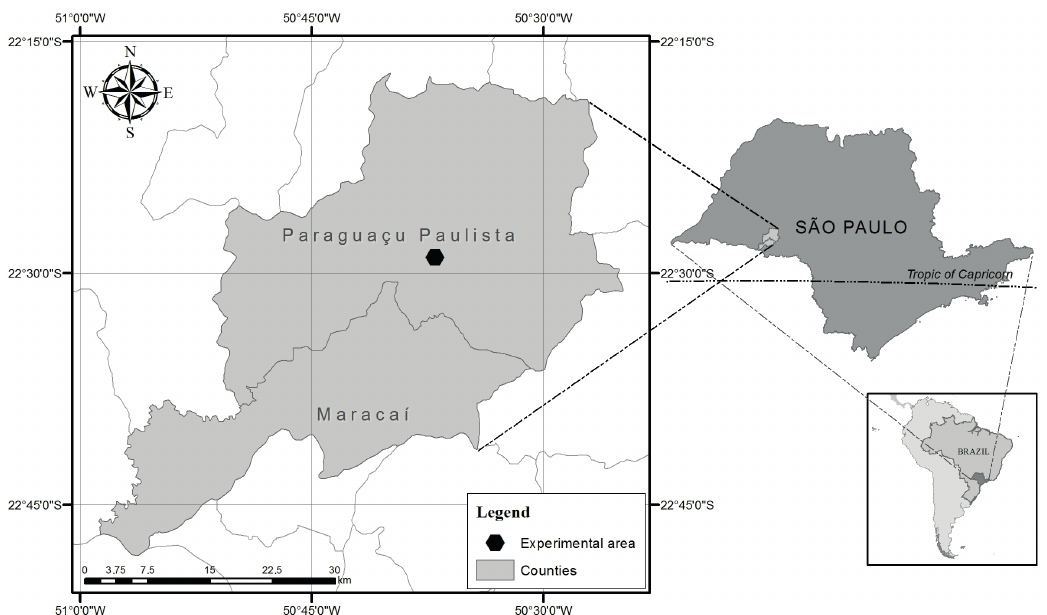
Figure 1 - Map of Brazil showing the state of São Paulo, map of São Paulo state showing the municipalities and the map of municipalities, showing the approximate localization of the experimental